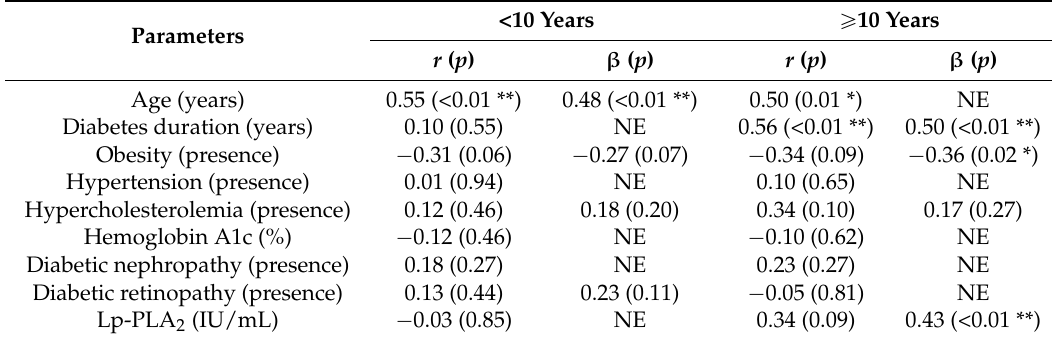
Table 2. Correlations with the CAVI levels according to the diabetes